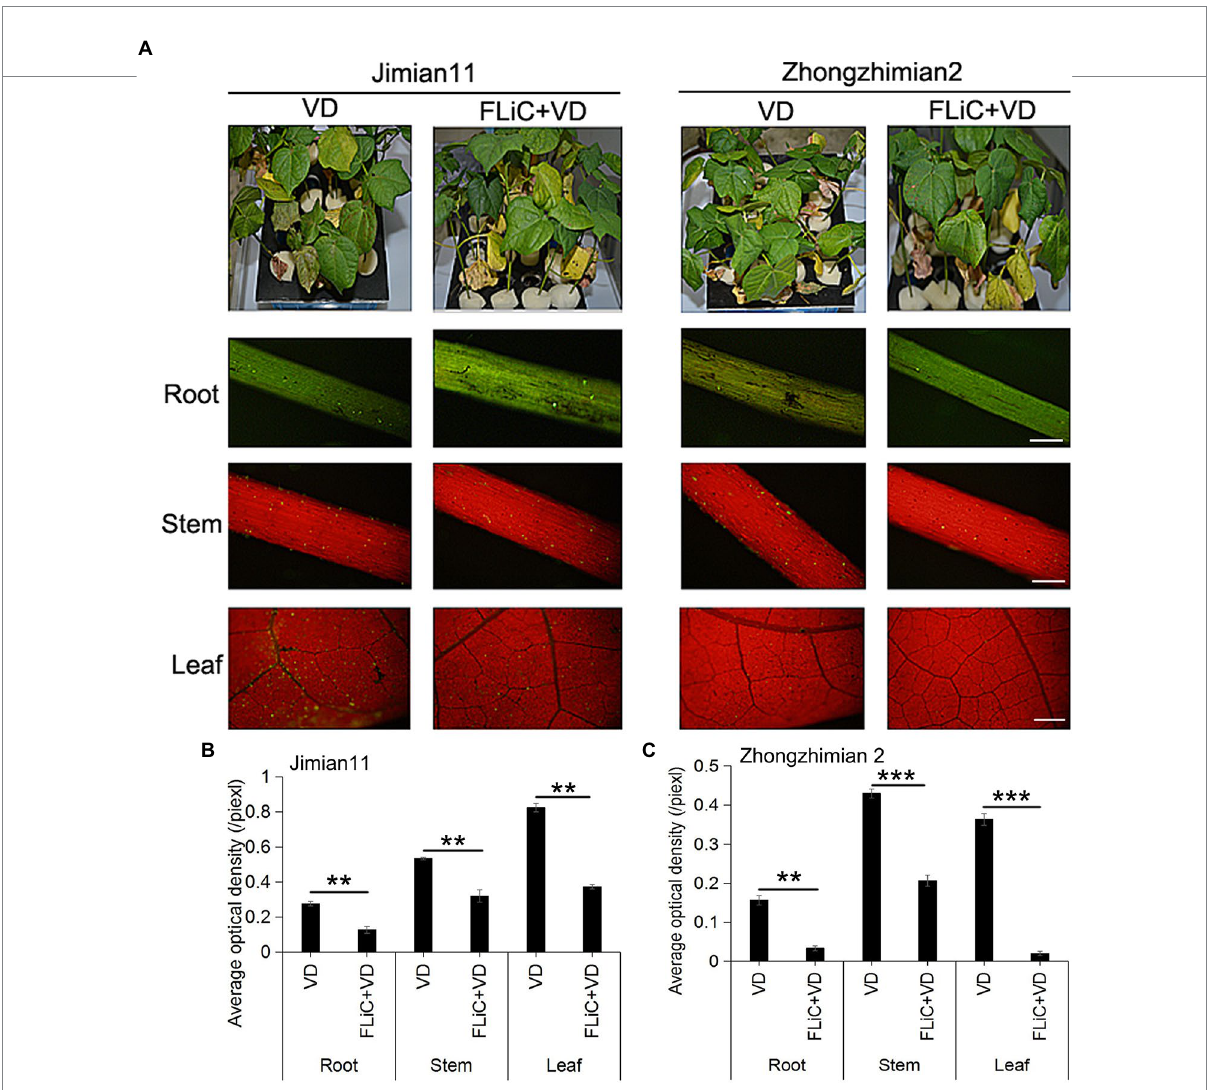
FIGURE 2 Effect of FLiC on infection with VD in Jimian 11 and Zhongzhimian 2. (A) Differences in phenotype and spore colonization of the roots, stems, and leaves between the disease-resistant variety Zhongzhimian 2 and the susceptible variety Jimian 11. (B) Statistics of the average fluorescence density of spores in the roots, stems, and leaves of Jimian 11. (C) Statistics of the average fluorescence density of spores in the roots, stems, and leaves of Zhongzhimian 2. The data represent the means ± SDs; n = 3 (** p < 0.01; *** p < 0.001; t test).Bars = 500 μ